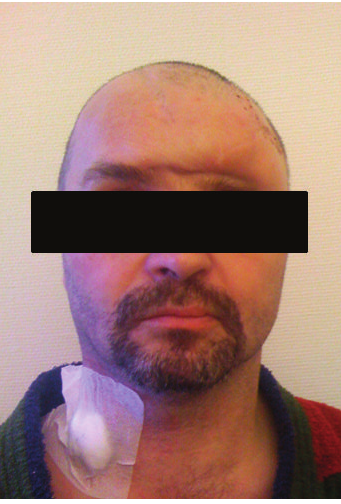
Figure 5: Showing the patient one week after surgery. The missing bone has been replaced by the titanium cranioplasty prosthesis. Wound healing was excellent and the excess skin flattened. A prosthesis will be fitted to replace his right